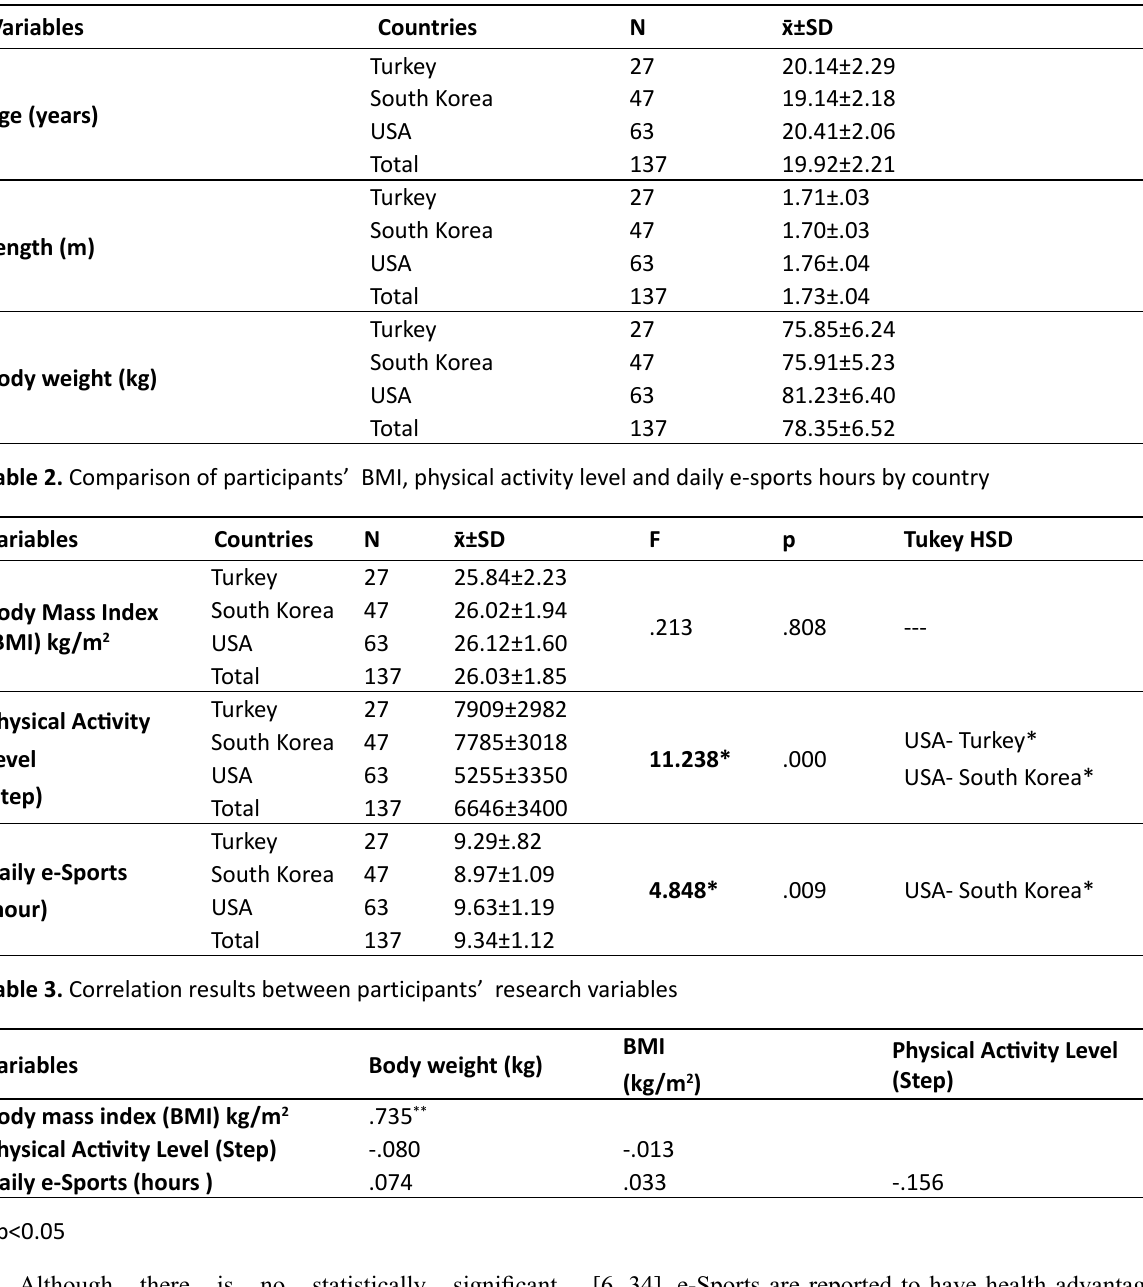
Table 1. Average age, height and body weight values of participants by country Variables